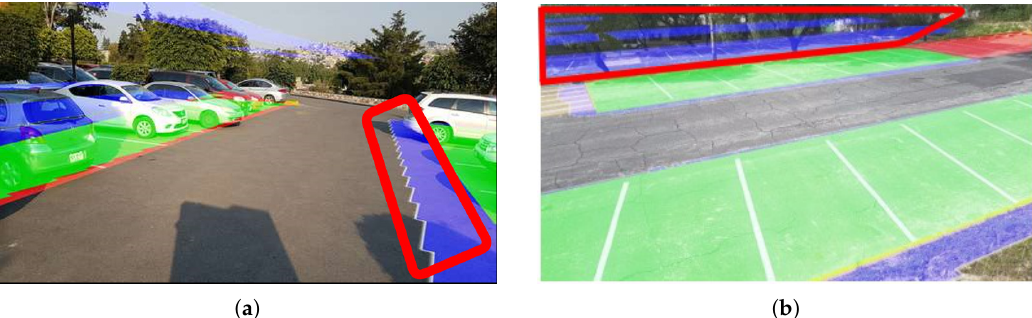
Figure 8. Parking lot examples from a camera perspective in which our method is prone to fail: ( a ) resolution mismatch, ( b ) multilevel parking lot. Red overlay stands for false negatives, blue for false positives and green for true positives. A red outline is shown around the aforementioned